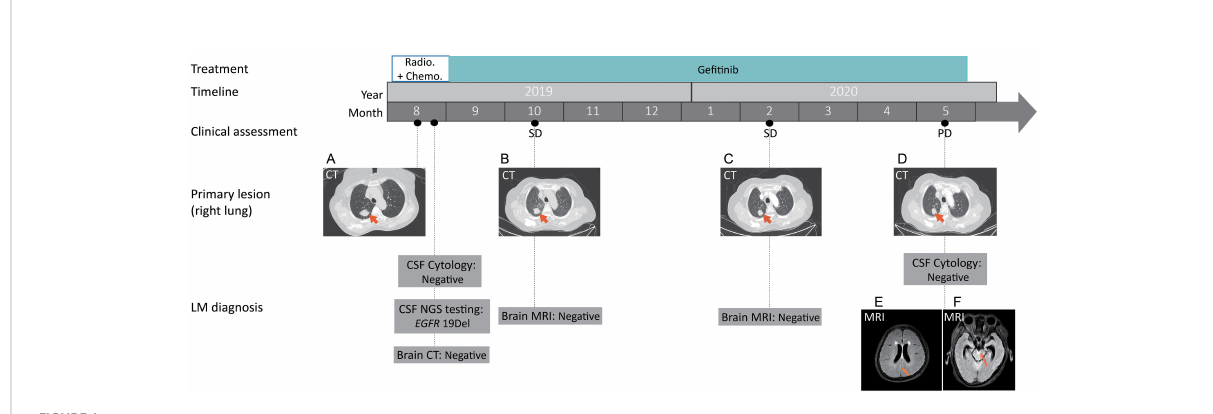
FIGURE 1 Treatment timeline with representative clinical evaluation and radiologic images. Based on the pathological analysis of the right lung biopsy, together with results from CT scans of the chest, abdomen and radionuclide bone, the patient was diagnosed with a clinical stage IVb LADC, T1cN2M1c according to the eighth edition of The American Joint Committee on Cancer (AJCC) TNM classi fi cation. (A) Computed tomography (CT) scans showed the primary tumor mass (biopsy site, arrows) in the right lung at the time of diagnosis; (B, C) Chest CT showing stable disease (SD) following ge fi nitib treatment; (D) Chest CT showing stable disease in the primary lung site at disease progression. (E, F) Magnetic resonance imaging (MRI) showing the potential metastatic site (arrows) in leptomeninges. SD, stable disease; PD, progressive disease; NGS, next-generation sequencing. CSF, cerebrospinal fl